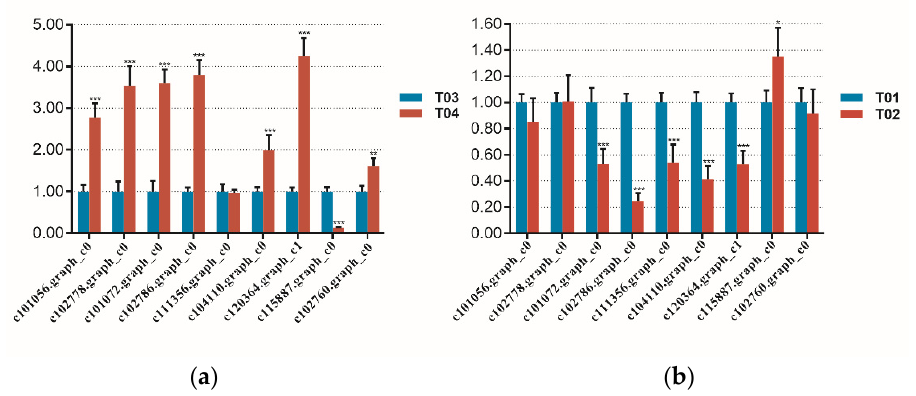
Figure 7. The relative mRNA expression of 9 DEGs quantified by qRT-PCR(One-way ANOVA was performed by SPSS Ststistics 17. ***, p < 0.01; **, p < 0.05; *, p < 0.1). ( a ) the relative mRNA expression of 9 DEGs in bulk T03 and T04. ( b ) the relative mRNA expression of 9 DEGs in bulk T01 and T02.